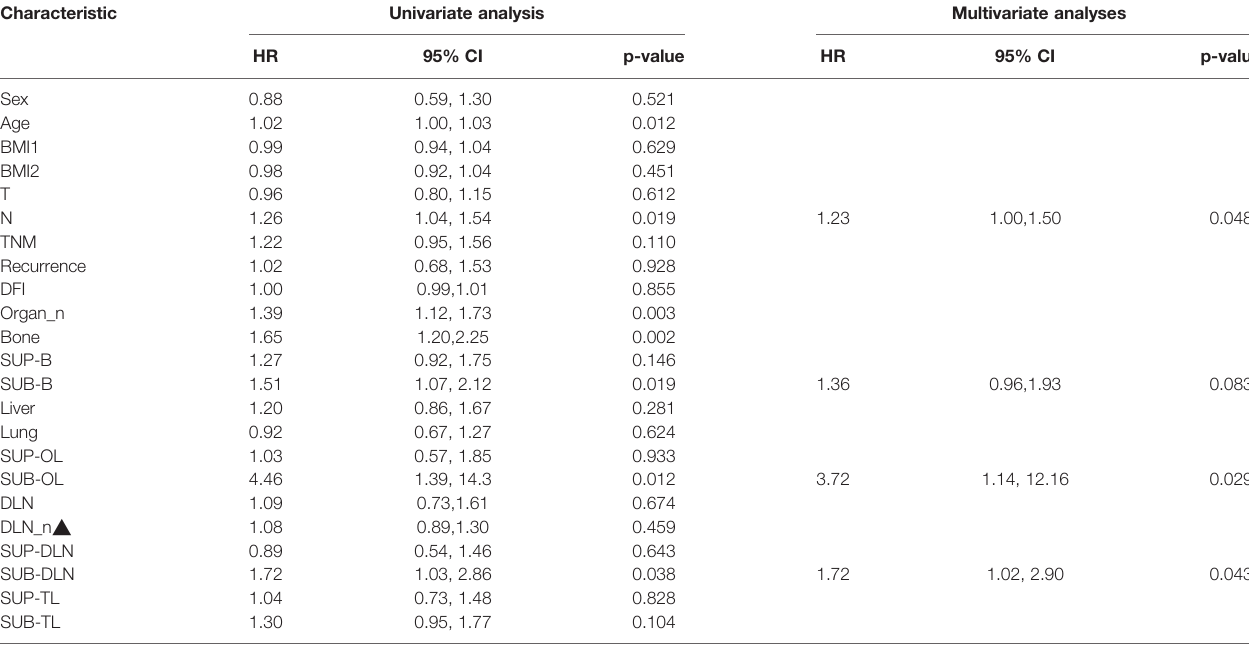
TABLE 3 | Univariate analysis and multivariate analyses of clinicopathologic characteristics.